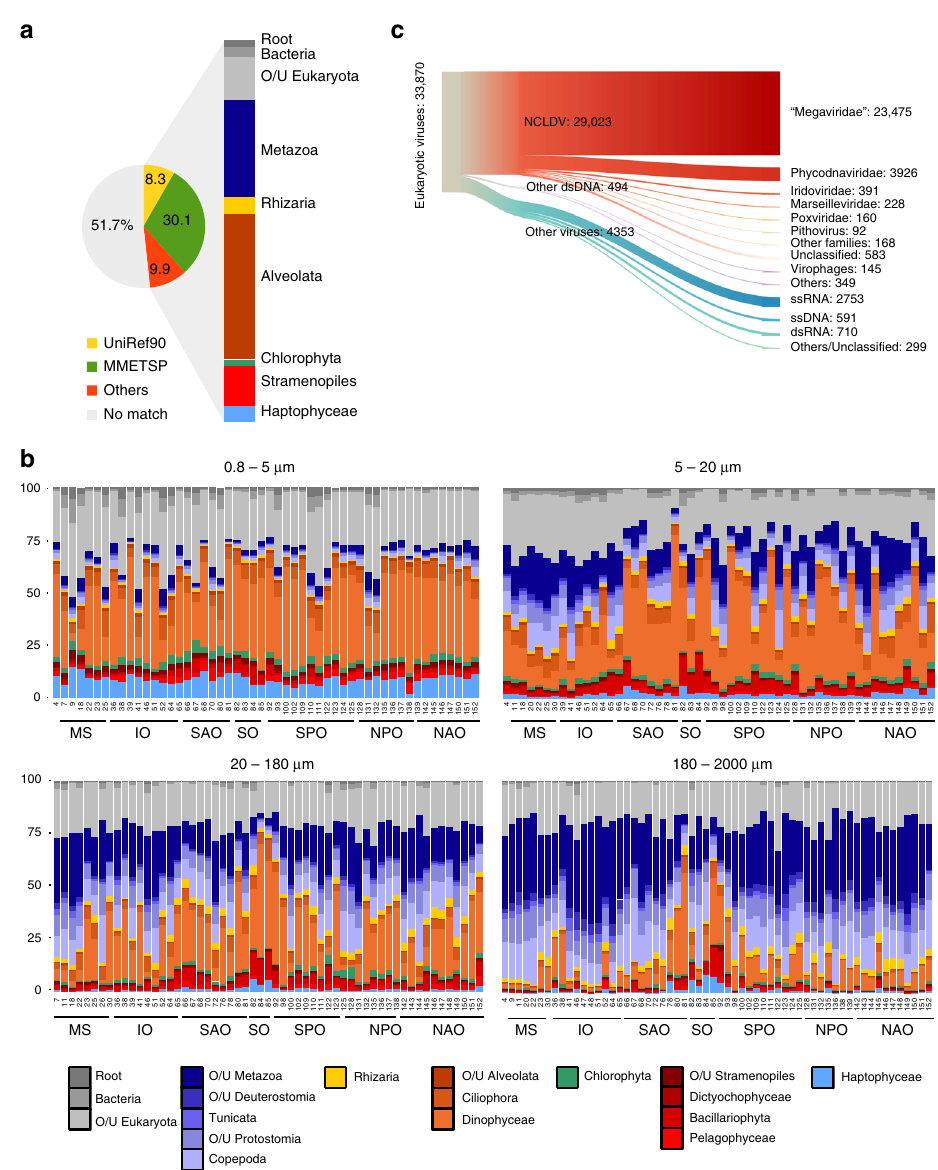
Fig. 2 Taxonomic composition of the gene catalog. a Origin of the best similarity sequence match as a fraction of the total in the circular diagram (MMETSP 14 : release of August 2014, with manual curation; UniRef90 42 : release of September 2014; “ Others ” : are other reference transcriptomes that were added as reference to offset the lack of knowledge about organisms in large size fractions, in particular copepods and rhizaria; Methods section). Unigenes without signi fi cant matches (i.e., those with an e -value > 10 – 5 for their best similarity match) are tagged as “ No match ” . The proportion of unigenes af fi liated to each major taxonomic group is indicated in the right column. O/U, other or unassigned. b Proportion of each major taxonomic group across Tara Oceans stations based on the mean number of unigenes classi fi ed as one of 24 different single-copy ribosomal proteins detected in each sample (IO, Indian Ocean; MS, Mediterranean Sea; NAO, North Atlantic Ocean; NPO, North Paci fi c Ocean; SAO, South Atlantic Ocean; SO, Southern Ocean; SPO, South Paci fi c Ocean). c Eukaryotic viral unigenes. NCLDV unigenes are classi fi ed at the family